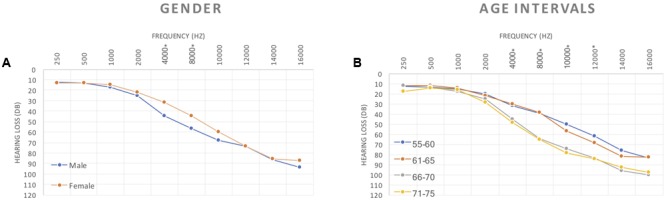
Tonal audiogram curves showing differences between: (A) gender and (B) age intervals, for all the frequencies used to estimate HL status.